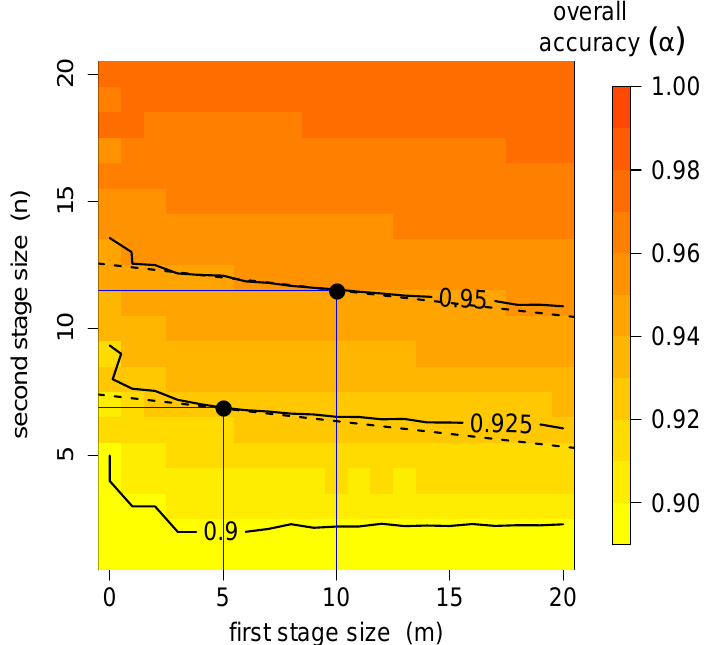
Figure 4. The overall classification accuracy α for BF2 as a function of m and n , the first stage and second stage sizes for p 1 = 0.9, θ = 0.7, a = 6 and b = 4. The solid lines are the iso-accuracy lines, corresponding to combinations of m and n , resulting in the same accuracy. The dashed lines are the iso-cost lines, corresponding to combinations of m and n , resulting in the same cost or effort. The tangent points of iso-cost and iso-accuracy lines correspond to optimal resource